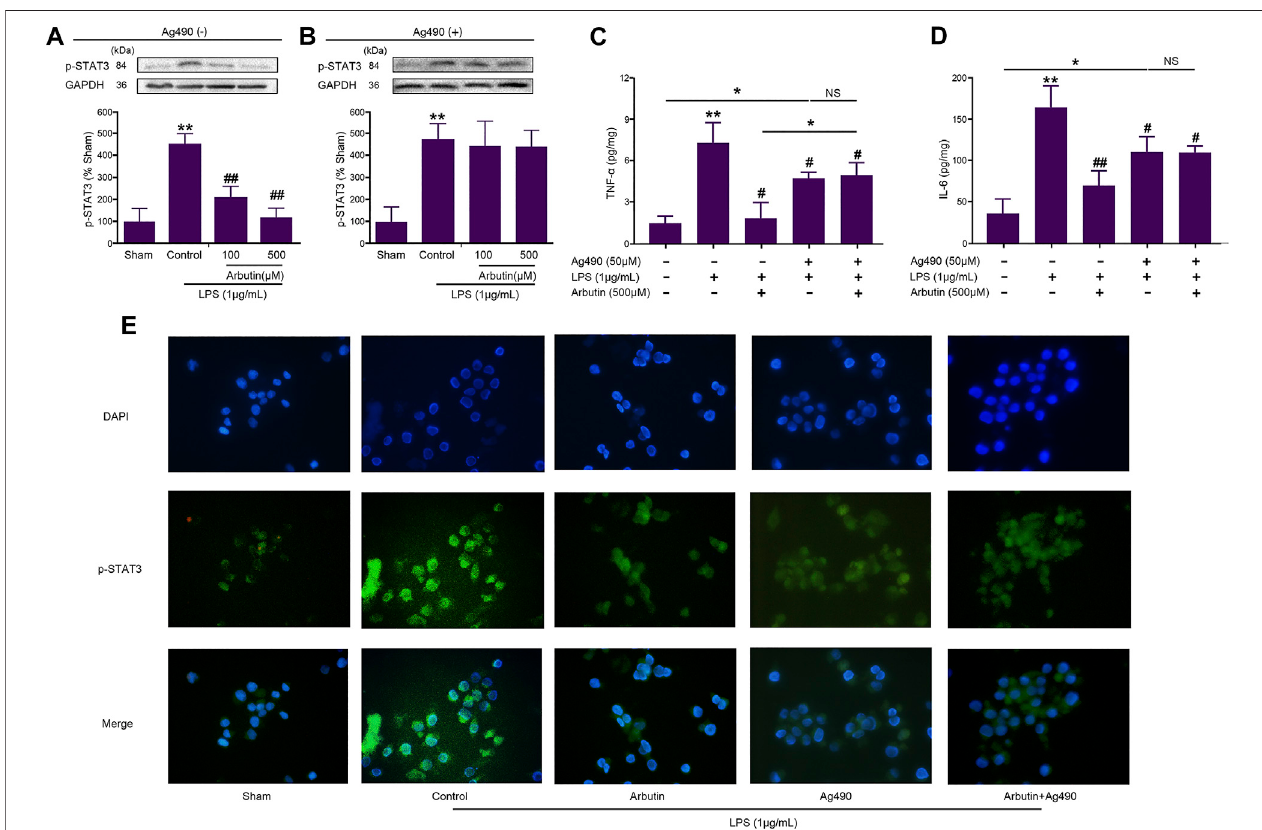
FIGURE8| EffectsofarbutinandAg490onLPS-stimulatedIEC6andRAW264.7cells (A) IEC-6cellsweregivenarbutin(100and500 μ M)for12 haftertreatment with LPS (1 μ g/ml) for 12 h and the level of p-STAT3 was determined by western blot analysis (B) IEC-6 cells were pretreated with AG490 (50 μ M) for 1 h, treated with LPS (1 μ g/ml) for12 h, and givenarbutin(100and 500 μ M) for12 h. Then thelevel ofp-STAT3wasdetectedbywestern blotanalysis (C , D) IEC-6 cellswere pretreated withAG490(50 μ M)for1 h,LPS(1 μ g/ml)for12 h,andthentreatedwitharbutin(500 μ M)for12 h,respectively.TheTNF- α andIL-6levelsweredetectedbyELISA (E) RAW 264.7 cells were pretreated with AG490 (50 μ M) for 1 h, treated with LPS (1 μ g/ml) for 12 h, and given arbutin (500 μ M) for 12 h, and the p-STAT3 expression was detected by immuno fl uorescence as described in the Materials and Methods . Data were expressed as mean ± SD. * p < 0.05 compared between the indicated groups; ** p < 0.01 Compared with sham group; # p < 0.05 compared with LPS control group; ## p < 0.01 compared with LPS control group; NS p > 0.05 compared between the indicated